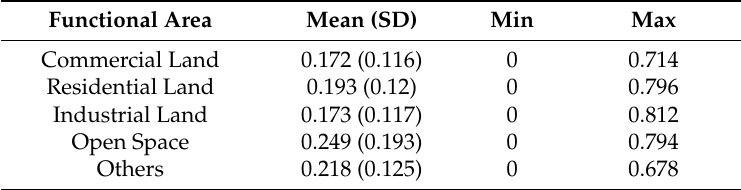
Table 4. Summary statistics of the green view index (GVI) in di ff erent urban functional zones (UFZs).